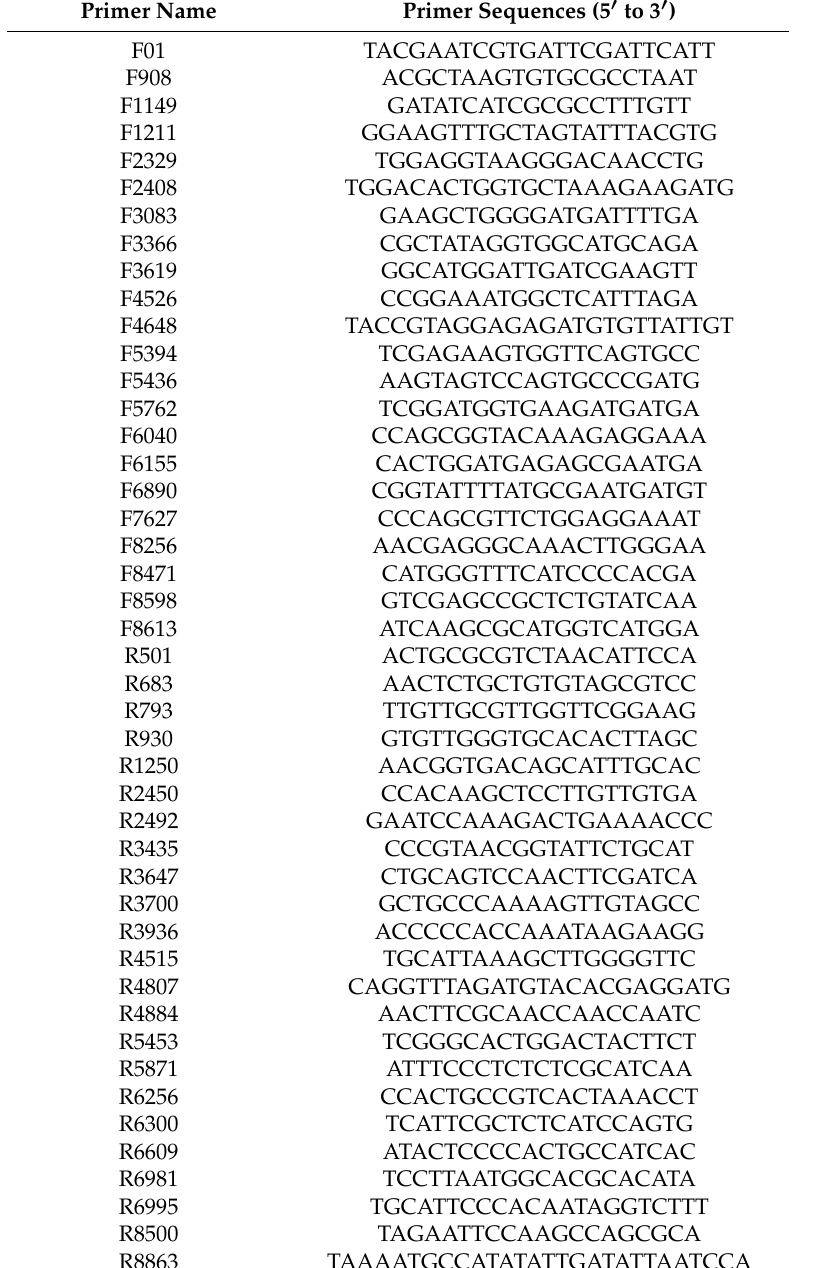
Table 1. Primers used in the RT-PCR, amplifying the overlapped SBV genomic fragments for sequencing. Primer